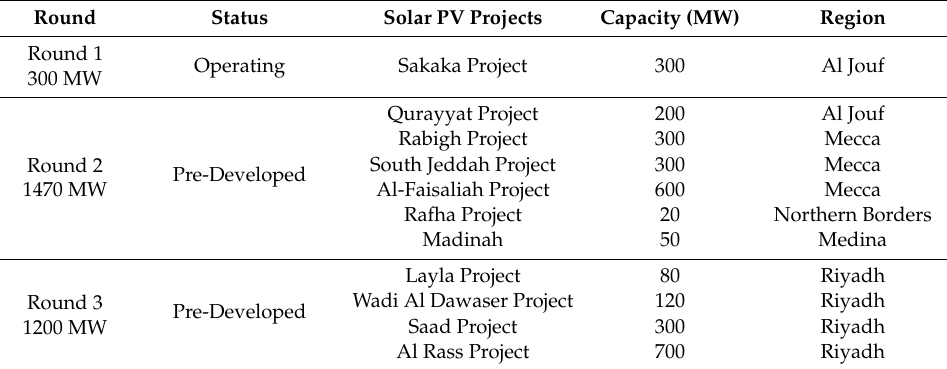
Table 11. Summary of future PV power projects in Saudi Arabia